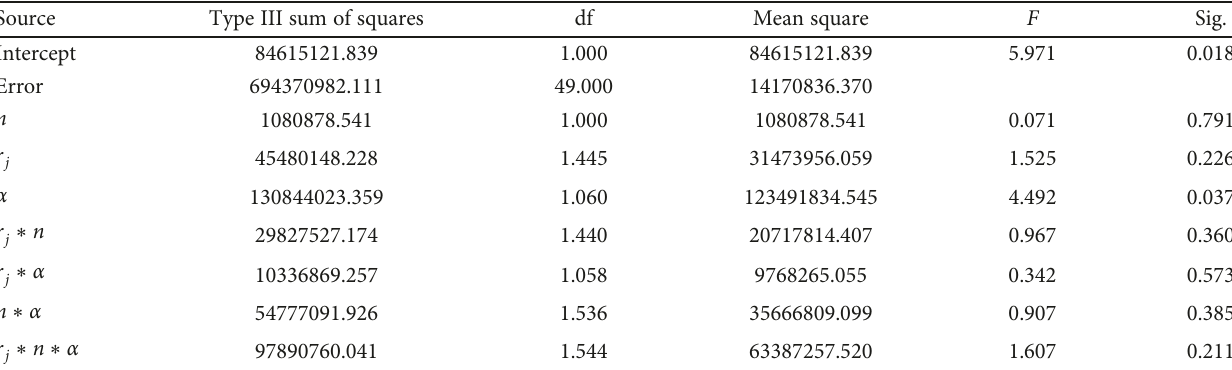
Table 7: Tests of between-subject e ff ects to IGD of MOMA.